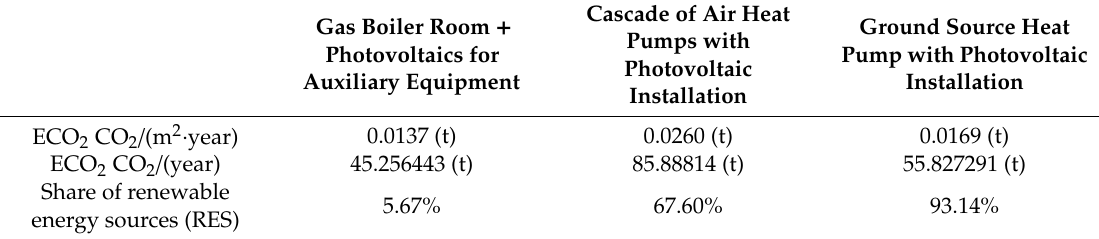
Table 17. The annual CO 2 emissions depending on the accepted heat source of the multi-family building at Akacjowa Street in